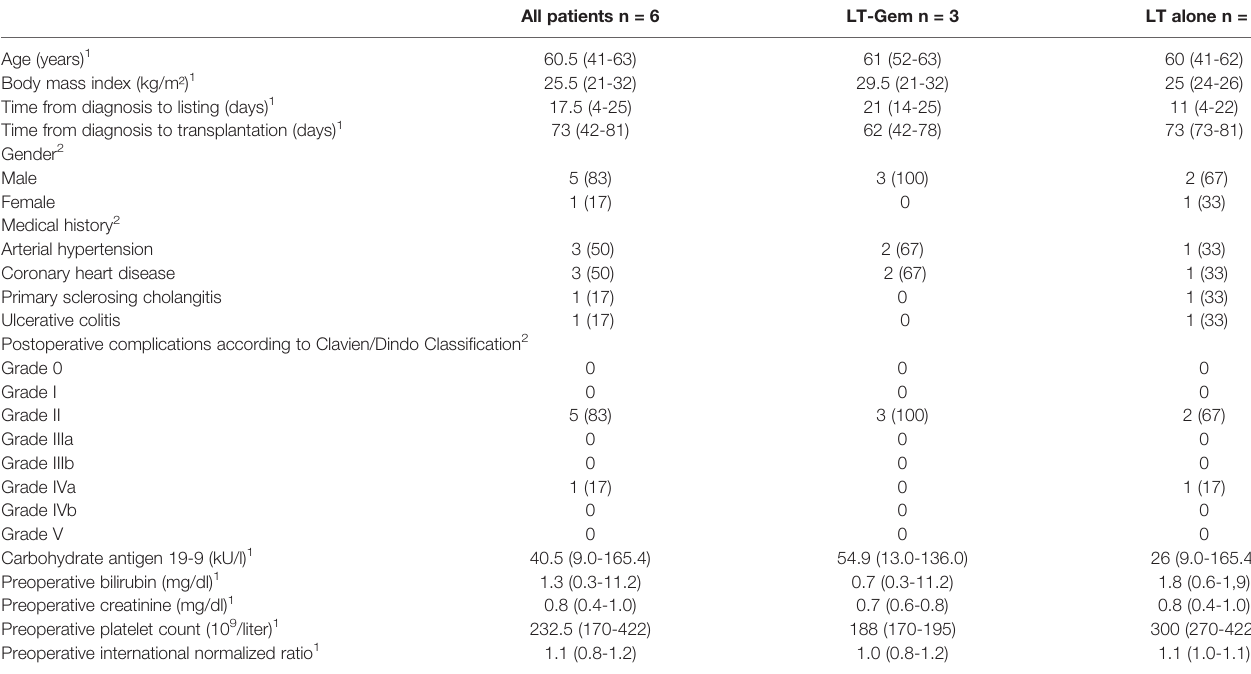
TABLE 1 | Baseline